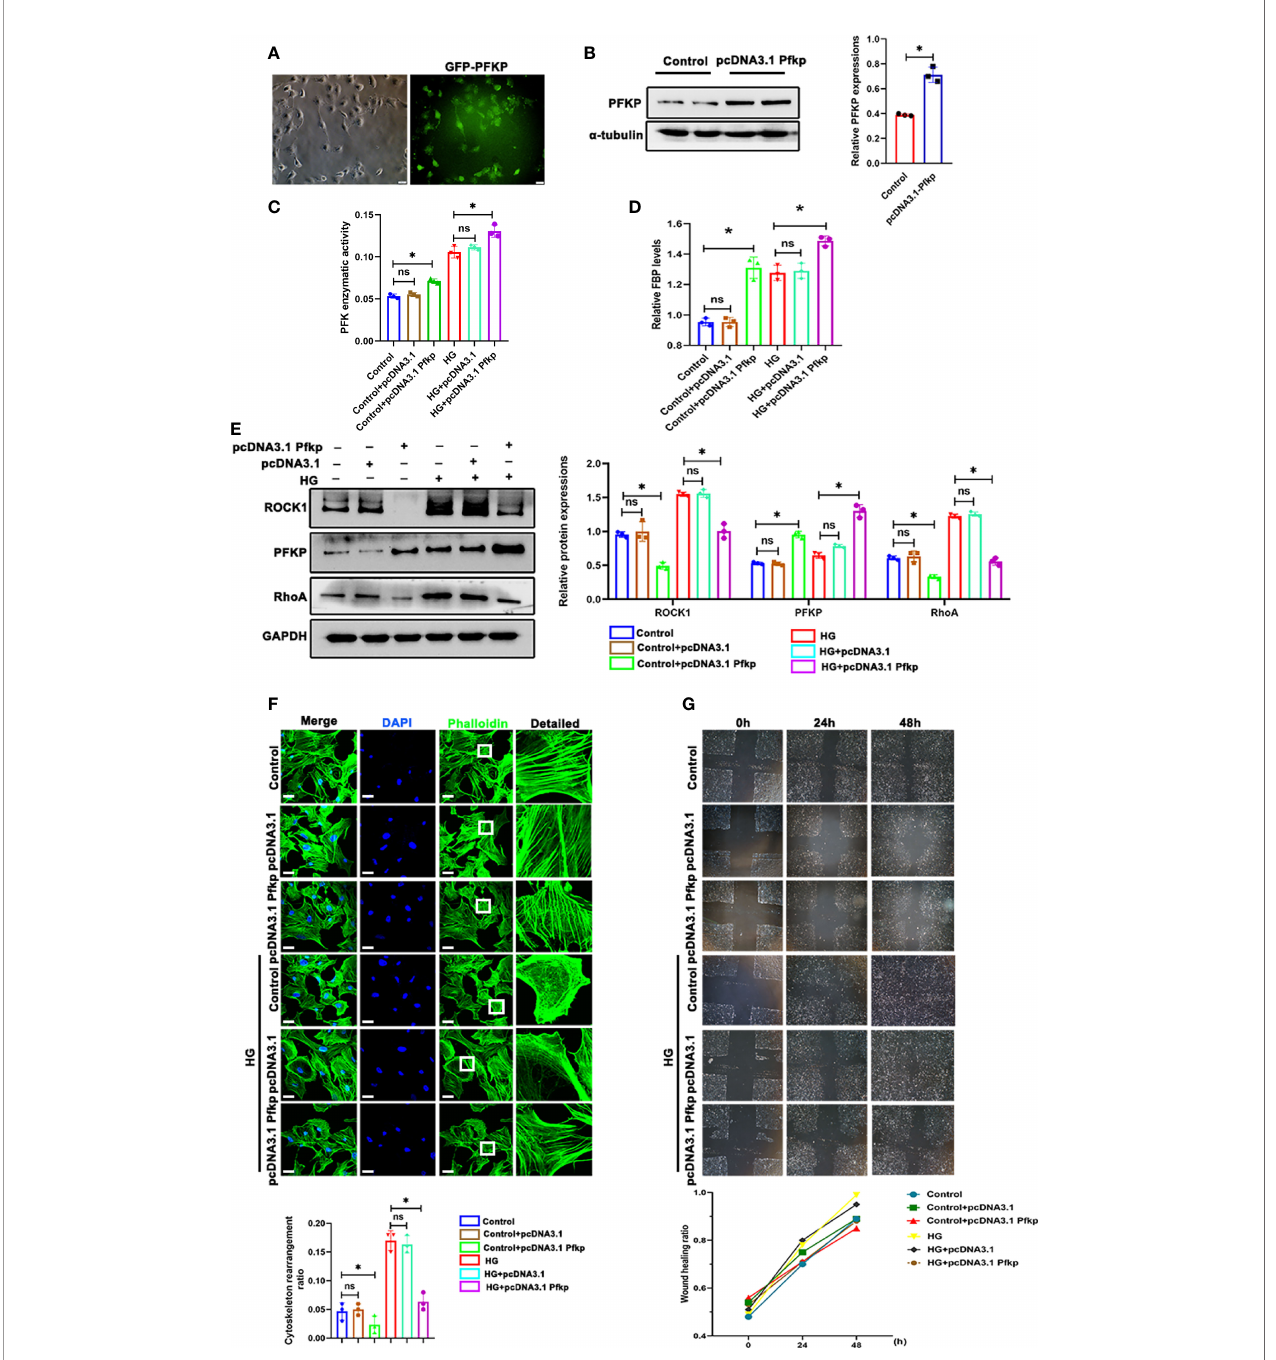
FIGURE 7 | Overexpression of PFKP ameliorated HG-induced cytoskeletal remodeling in podocytes in vitro . (A) After recombinant plasmid (pcDNA3.1-Pfkp) transfection into podocytes, the expression of EGFP was observed by fl uorescence microscopy. (B) Western blots of PFKP expression after transfection with pcDNA3.1-Pfkp, with GAPDH set as the loading control. (C) PFK enzymatic activity in each group. (D) FBP level in each group. (E) Western blotting analyses of the expression of ROCK1, PFKP, and RhoA in podocytes in each group. GAPDH was set as the loading control. (F) Cytoskeletal structures of podocytes labeled with phalloidin. (G) Motility of podocytes measured by a wound-healing assay using an inverted microscope. For all fi gures, n=3 independent experiments/group. * P < 0.05, ns, No signi fi cance. Scale bars: 10 µm. HG, high glucose; ROCK1, Rho-associated, coiled-coil containing protein kinase 1; PFKP, phosphofructokinase 1 platelet type; RhoA,